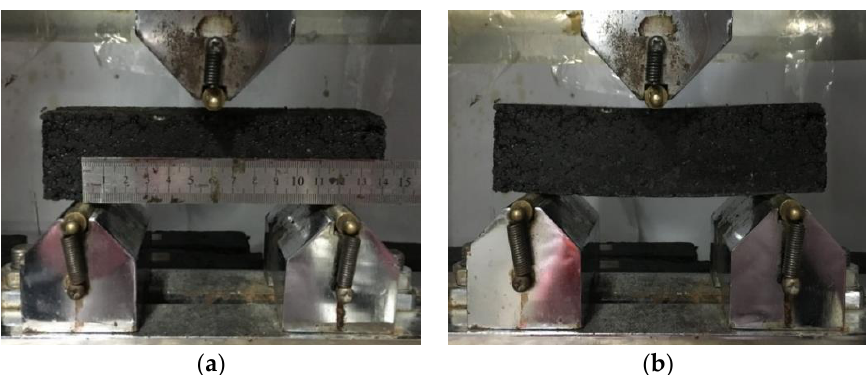
Figure 3. Loading of the fiber-reinforced asphalt mortar (FRAM) beam sample ( a ) before loading and ( b ) loading.